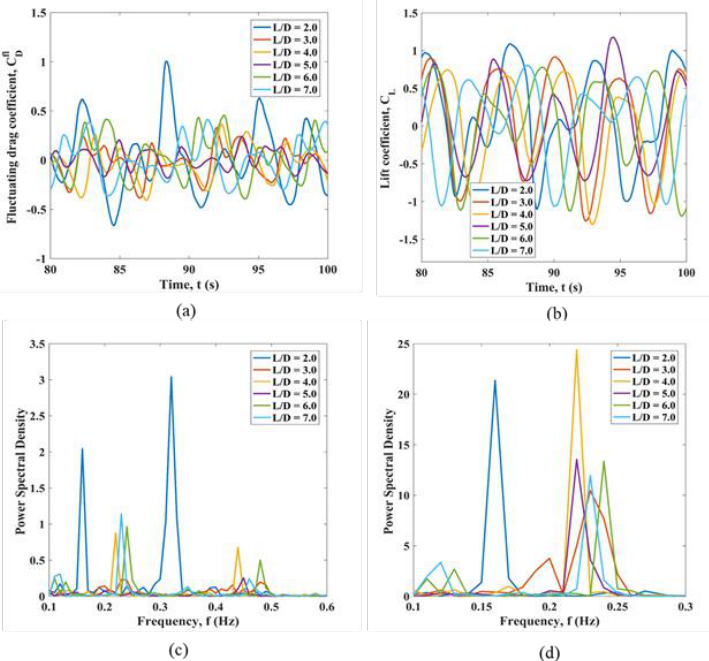
Figure A6. Fluid force coefficients for cylinder 2 immersed in planar sheared flow: ( a ) time history of the fluctuating drag coefficient; ( b ) time history of the lift coefficient; ( c ) the fluctuating drag co–efficient FFT; ( d ) the lift coefficient FFT.